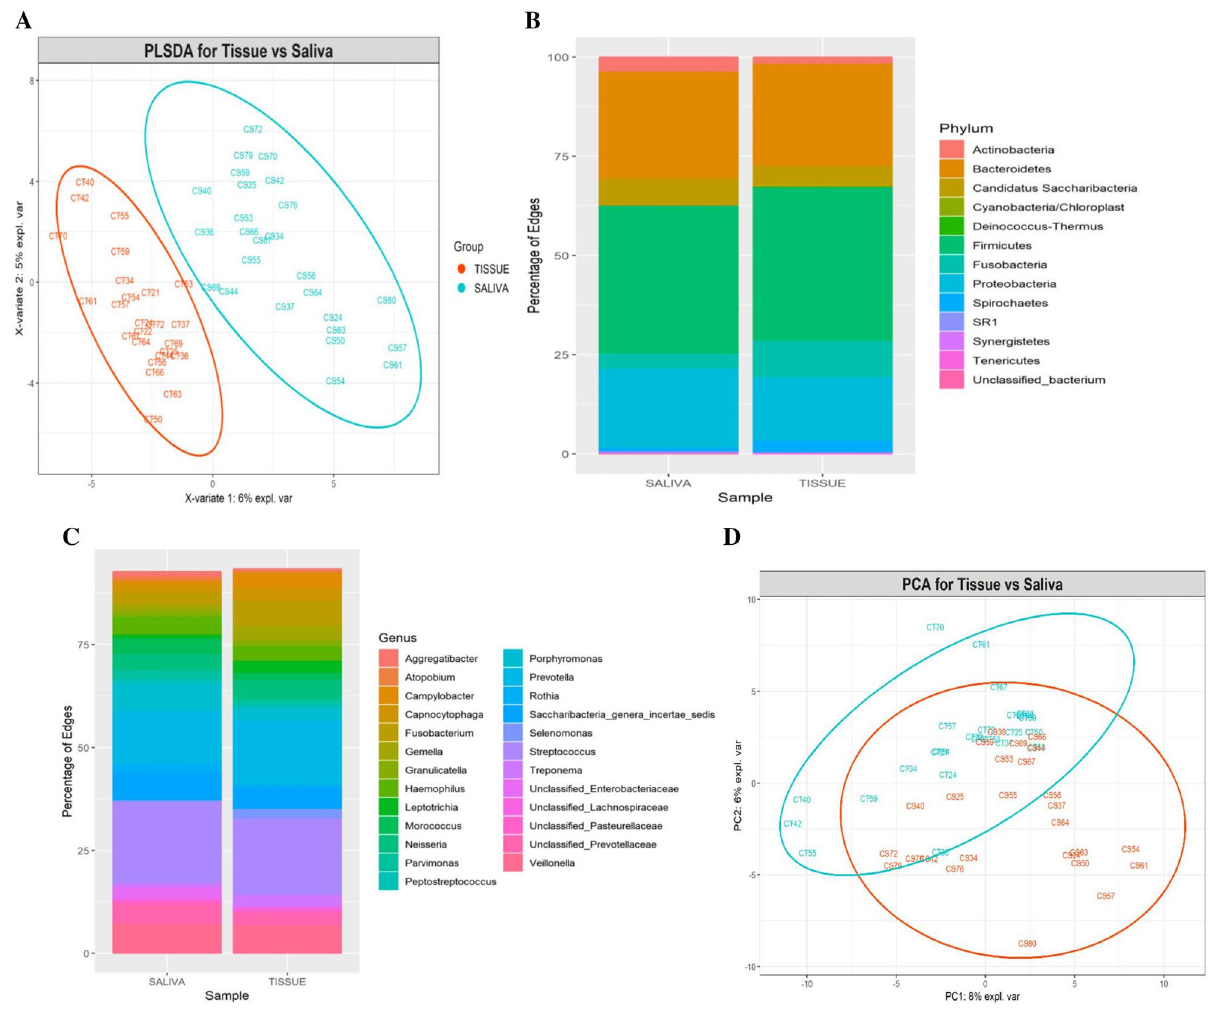
Figure 7. (A) Partial least square discriminant score plot of oral microbiota between the cancer tissue and WMF sample (P < 0.01). P value was determined by PERMANOVA. Percentage distributions of bacterial communities across samples at the phylum (B) and genus (C) levels ( D) PCA